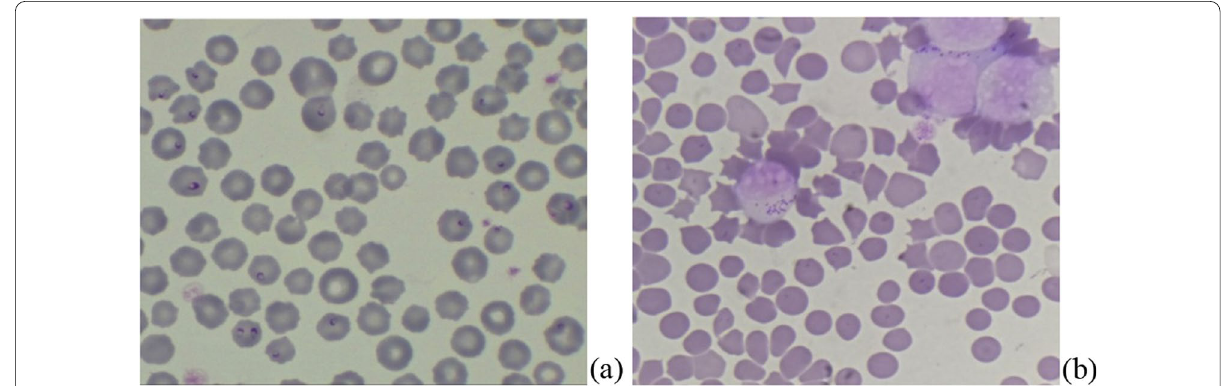
Fig. 1 a Giemsa-stained blood smear showing T. annulata infected in RBCs ( a ) and lymphocyte ( b )